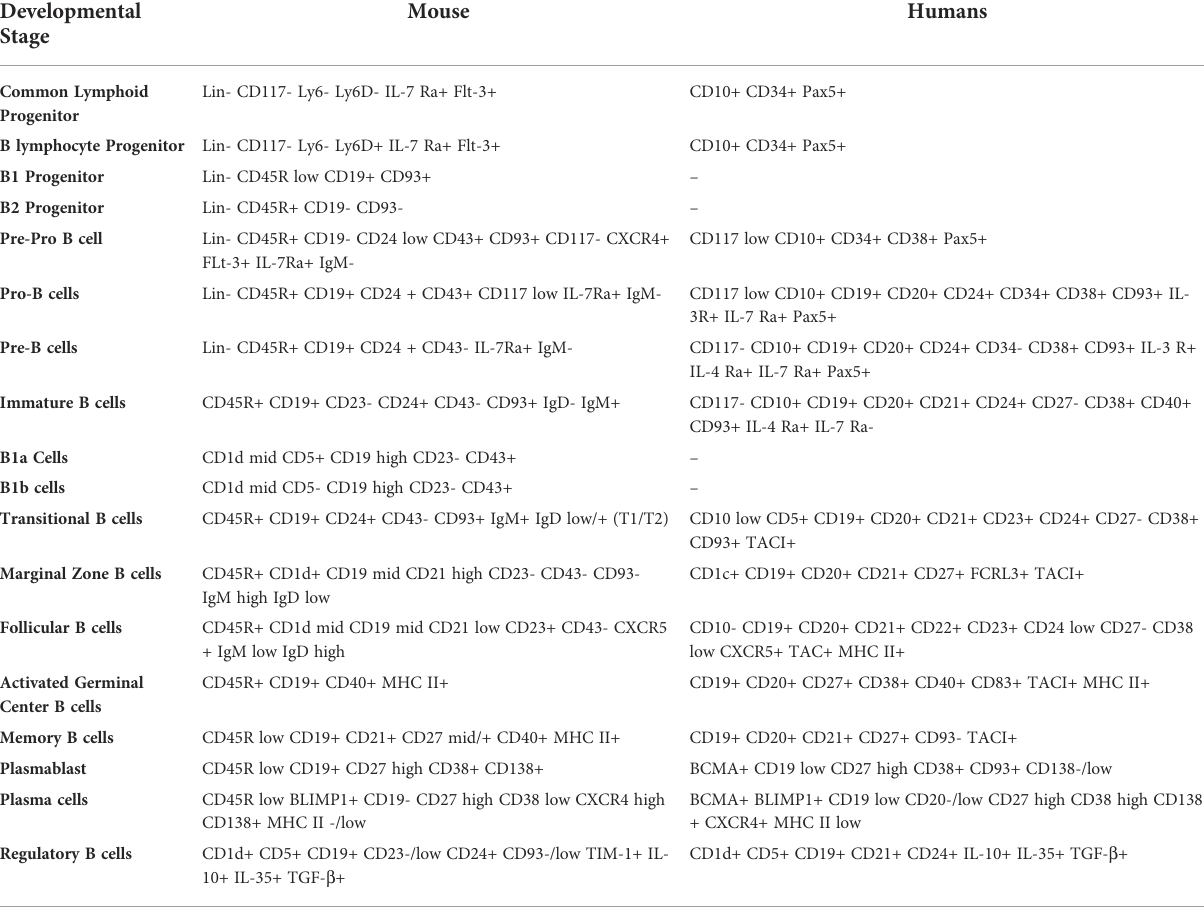
TABLE 1 Expression pro fi le of cell surface and intracellular markers characteristic of developmental stages of B cells in humans and mice.